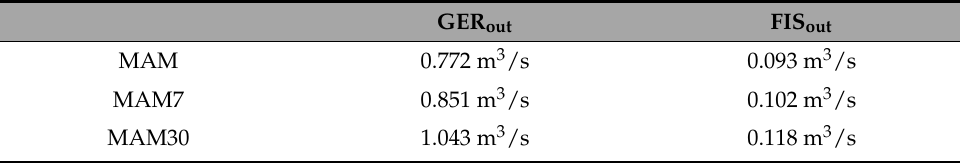
Table 6. Threshold values retrieved by averaging the AMIN, AMIN7, and AMIN30 time series. GER out FIS